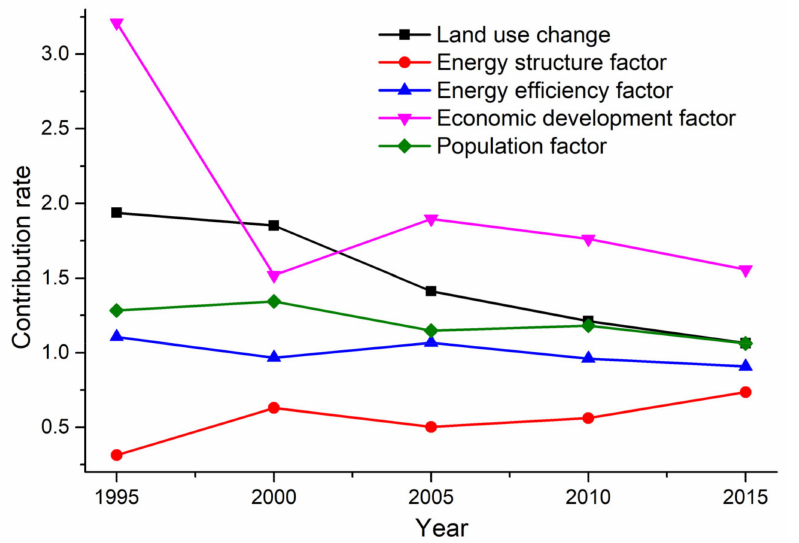
Figure 7. The contribution of decomposed influencing factors on land-use carbon emission in PRD. Note: 1995 denotes the contribution rate of each factor from 1990 to 1995, with other periods following this